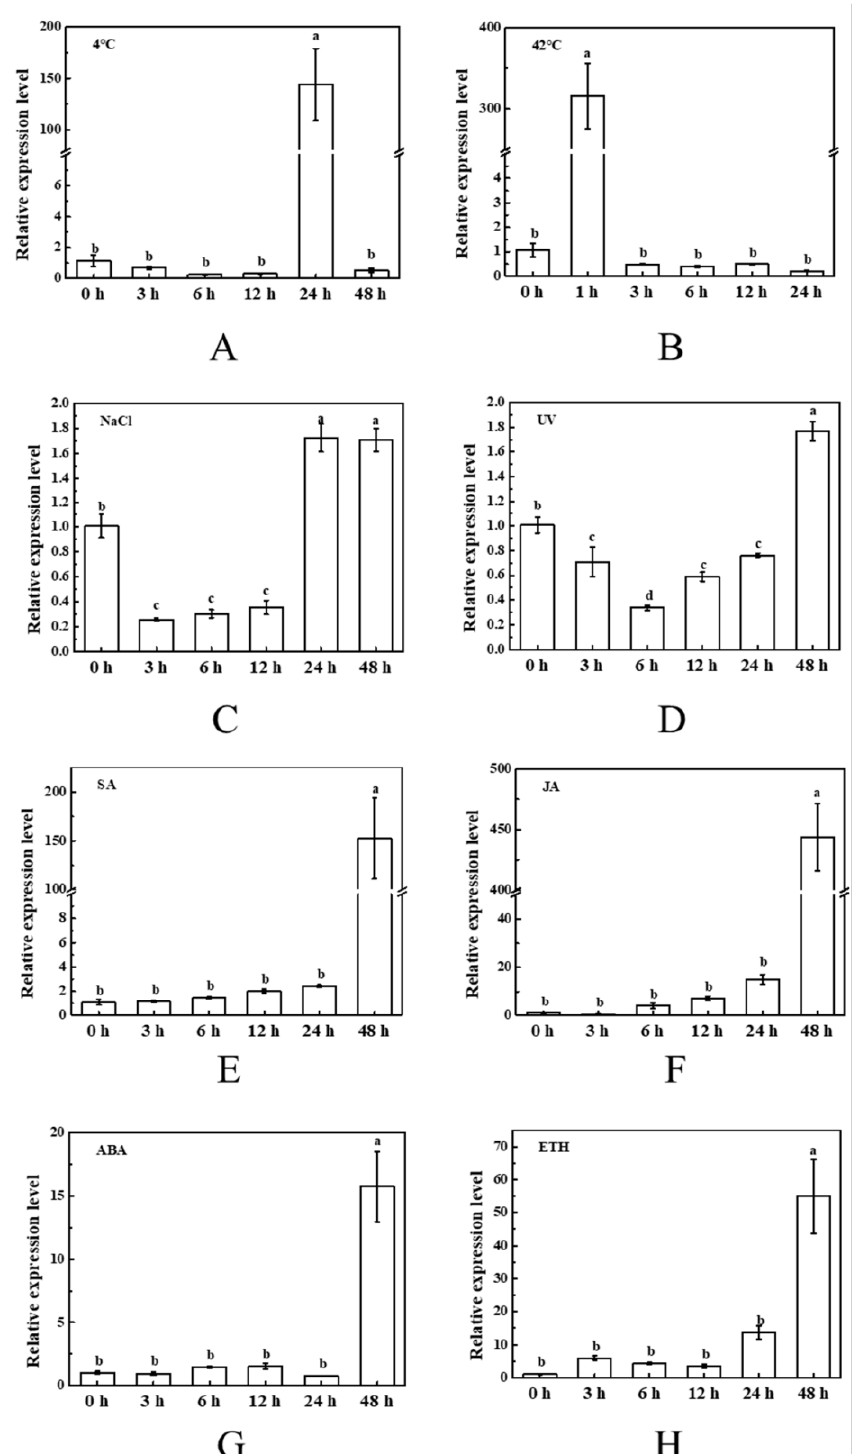
Figure 5. Responses of tomato BAG5b to different abiotic stresses and various hormones. Abiotic stresses: 4 ◦ C ( A ), 42 ◦ C ( B ), NaCl treatment ( C ), and UV irradiation ( D ). Hormone treatments: SA foliage spraying ( E ), JA foliage spraying ( F ), ABA foliage spraying ( G ), and ETH foliage spraying ( H ). Seedling growth conditions set as 14 h/10 h photoperiod with 150 µ mol m − 2 s − 1 light intensity, 23~25 ◦ C/18~20 ◦ C temperature period (except 4 or 42 ◦ C). The young leaf samples were collected at the indicated time points and analyzed by qPCR. For each treatment, the expression level at 0 h was set as 1.0. Different letters indicate expression levels that were significantly different at P <